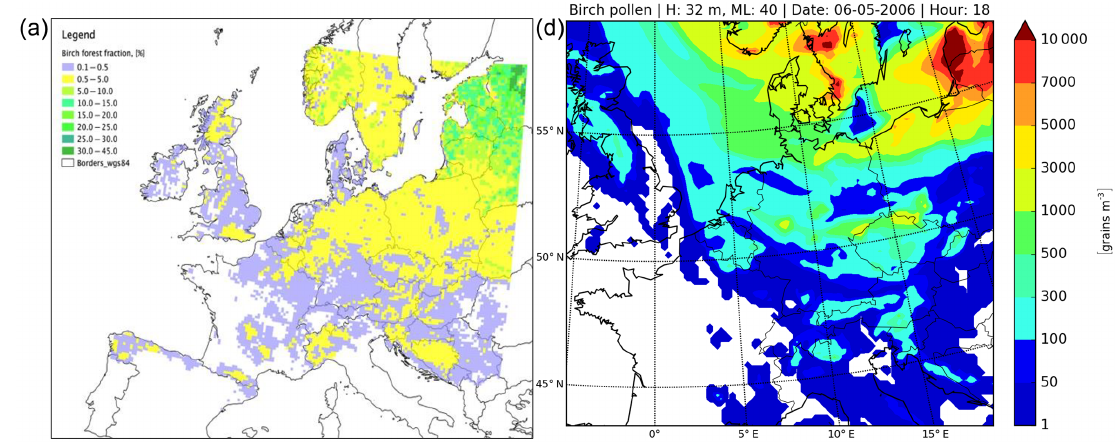
Figure 12. (a) Birch forest fraction map; (b) example of the simulated birch pollen concentration in the modelling domain on 6 May 2006 at 18:00UTC.